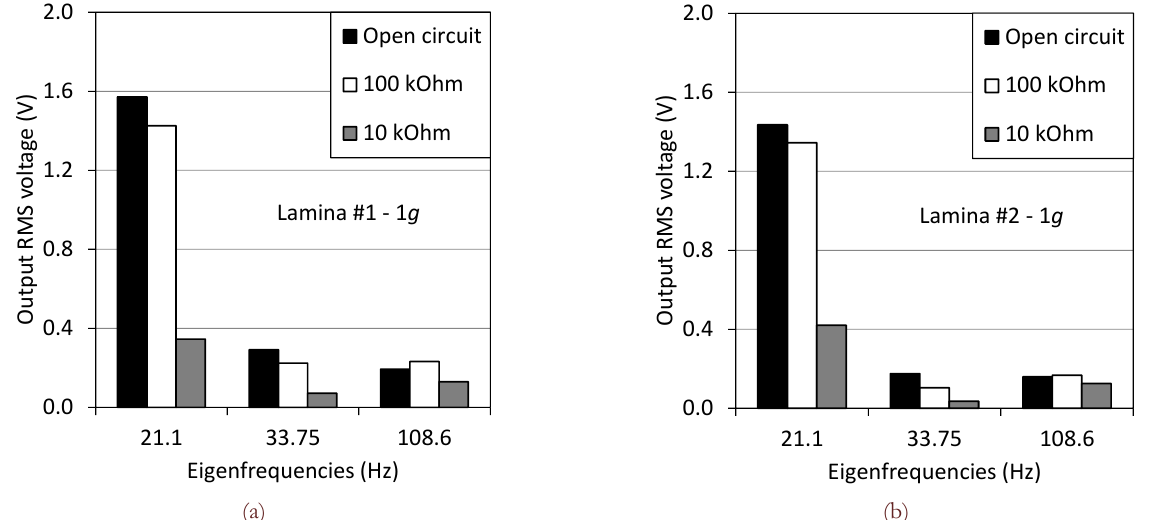
Figure 7: Bar charts of the output root mean square voltage measured experimentally for each eigenfrequency to an acceleration of 1g: lamina #1 (a), and lamina #2 (b).